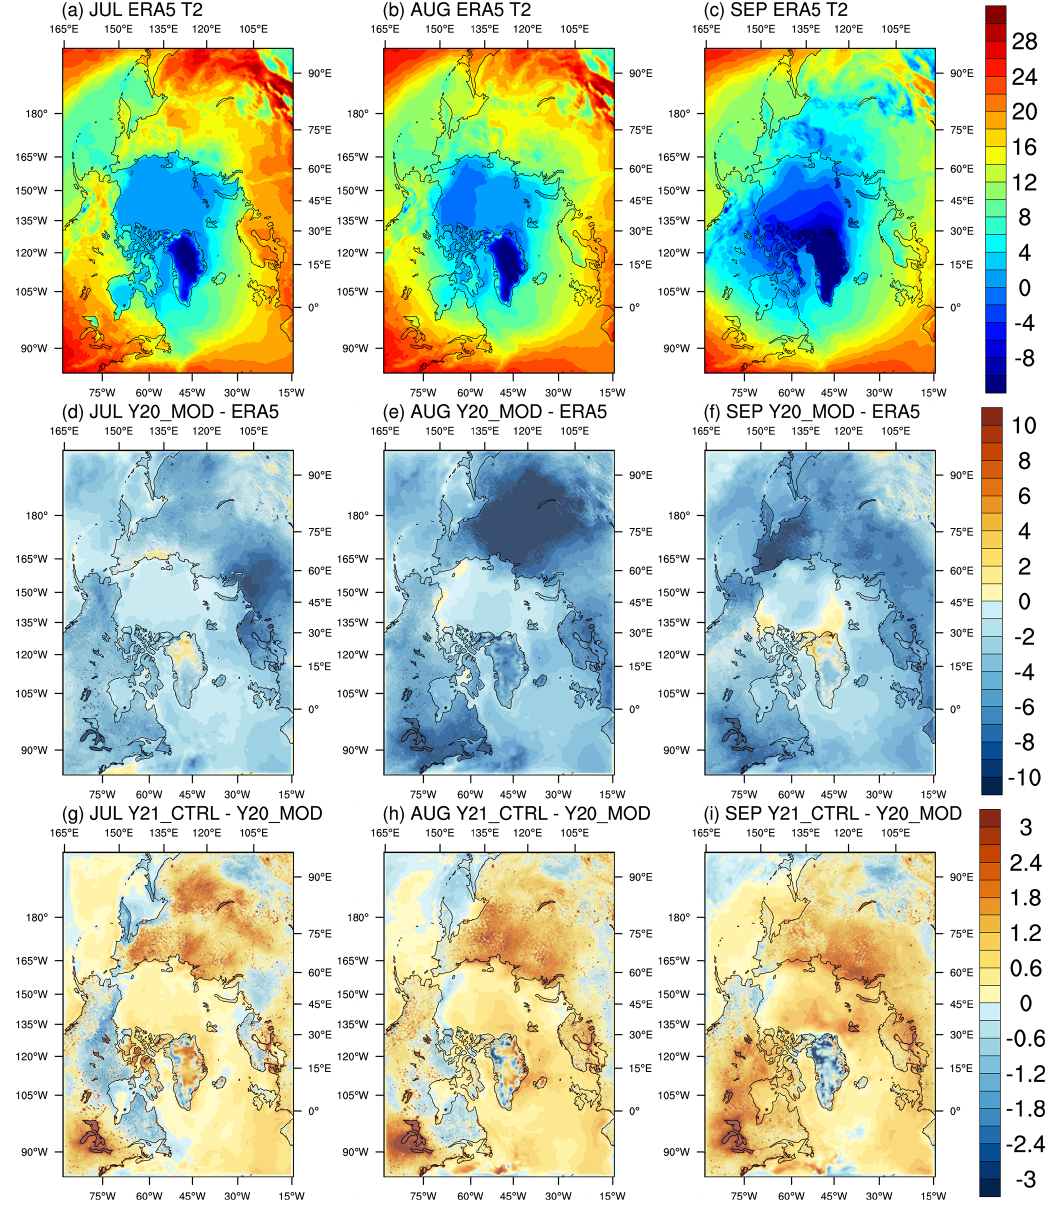
Figure 3. Same as Fig. 1 but for near-surface air